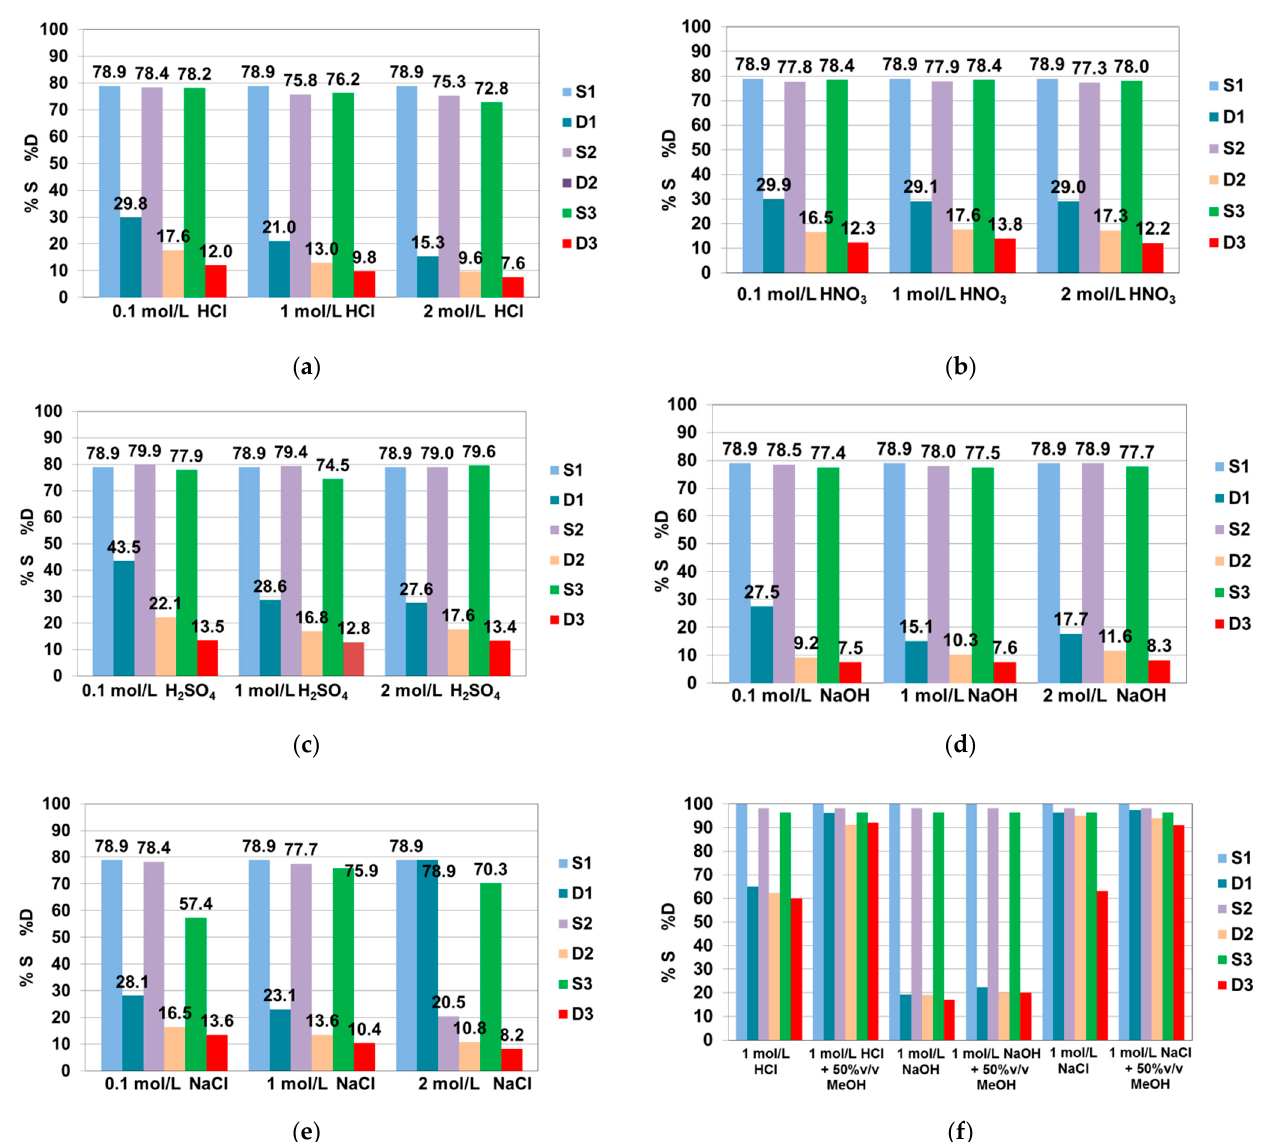
Figure 6. Regeneration of S5528 resin in three cycles of sorption (%S) and desorption (%D) for ( a–e ) Zn(II) and ( f ) AG16 dye using different eluting agents.